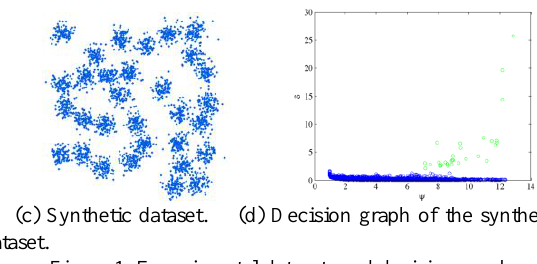
Figure 1. Experimental datasets and decision graphs.